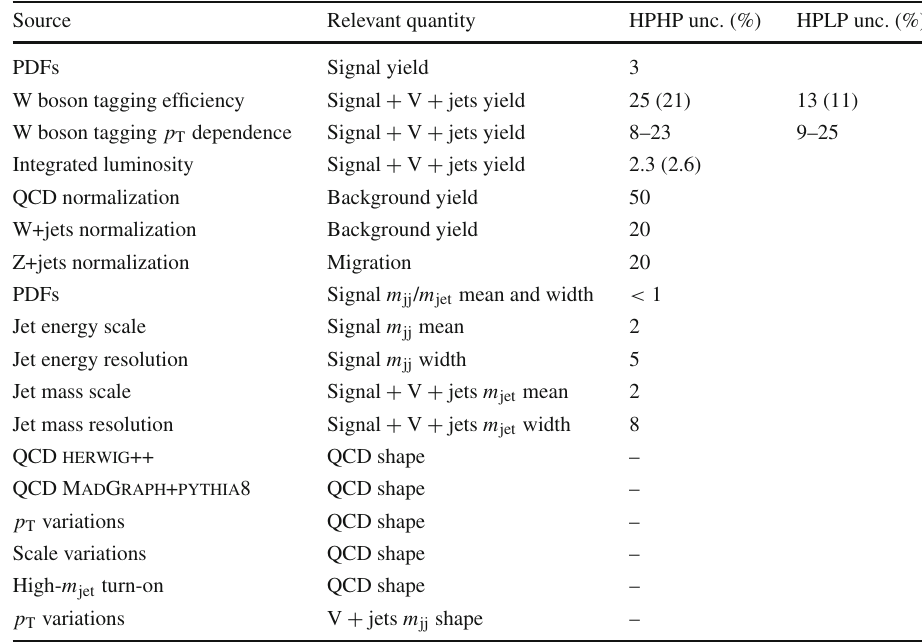
Table 2 Summary of the systematic uncertainties and their impact the affected quantities. Numbers in parentheses correspond to uncertainties for the 2016 analysis if these differ from those for 2017. Dashes indicate shape variations that cannot be described by a single parameter, and are discussed in the